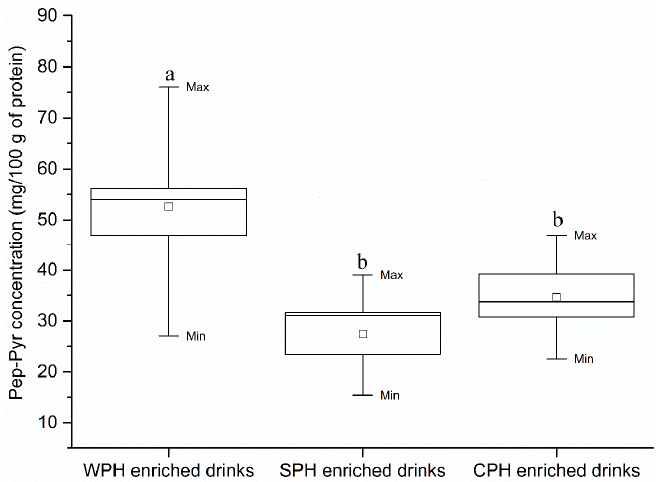
Figure 7. Box plot with whiskers from minimum to maximum of Pep-Pyr concentration in different groups of peptides enriched drinks clustered to the type of peptides source. □ is the mean value. Different characters (a, b) on boxes indicate significant difference between groups ( p < 0.05).